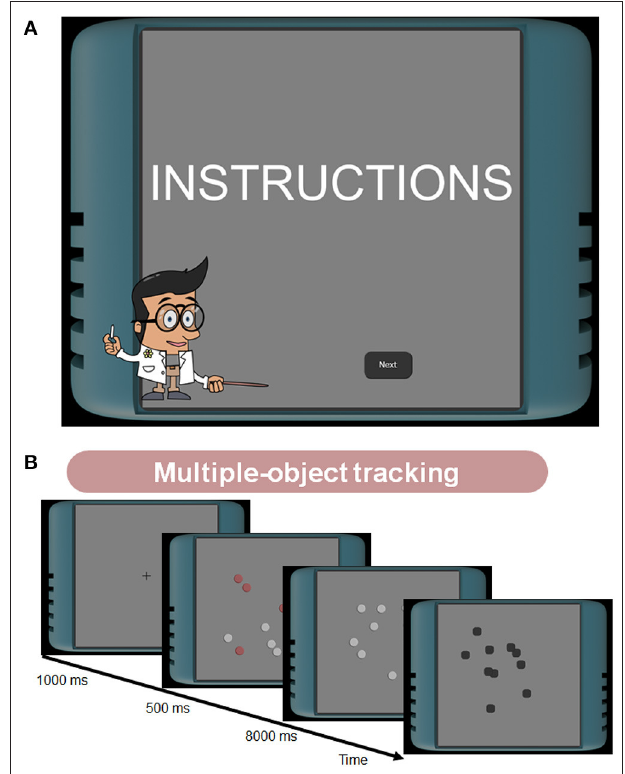
FIGURE 1 | (A) Interface example of the test battery. (B) Stimuli and tasks in the multiple-object tracking (MOT) task. After presenting the fixation point, five of the 10 discs were briefly highlighted in red to show they are the targets to track. Then, 10 objects started to move for 8s. Participants answered which are the target objects by clicking black boxes after the moving scene